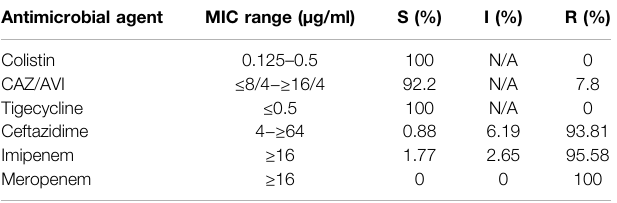
TABLE 1 | Antibiotic susceptibility characteristics of K. pneumoniae isolates. Antimicrobial